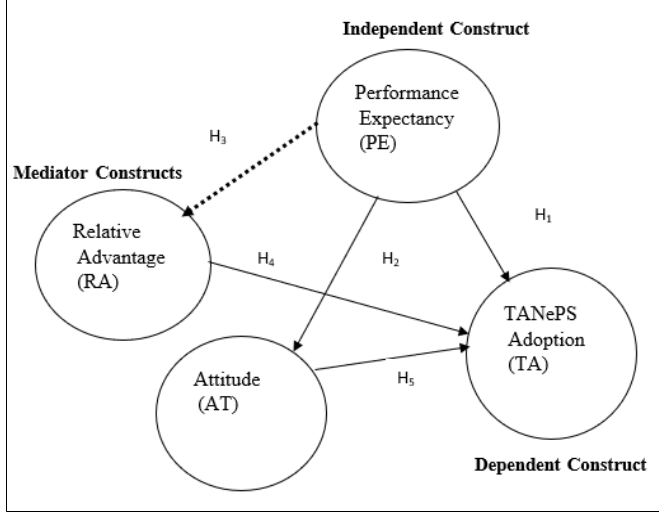
Figure 5: Conceptual Model of the